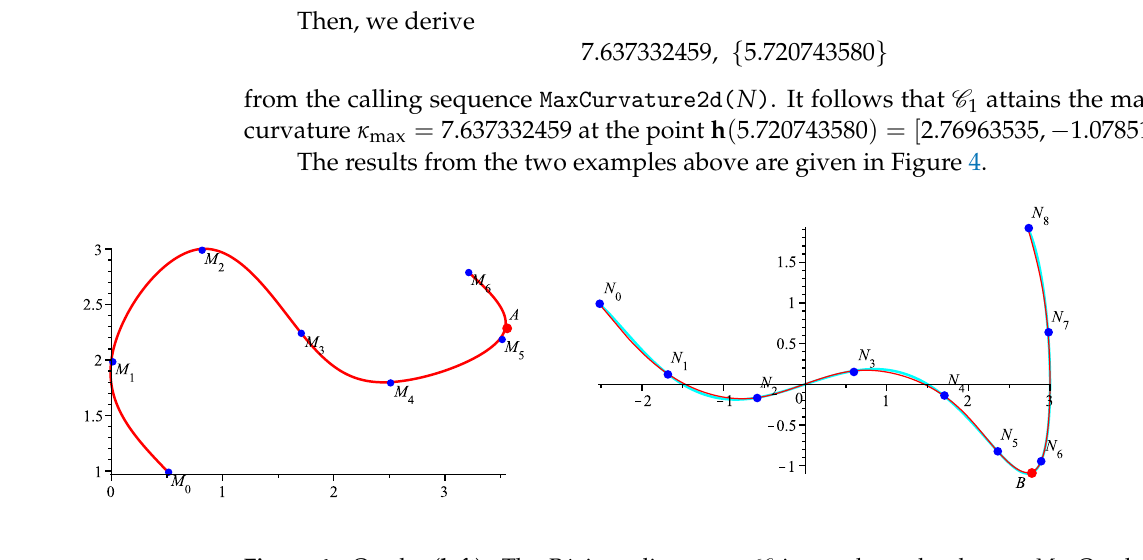
Figure 4. On the ( left ): The Bézier-spline curve C interpolates the dataset M . On the ( right ): The Bézier-spline curve C 1 (in red) interpolates the set N of points on L (in cyan). The red points A and B are the points of maximum curvature of C and C 1 , respectively.